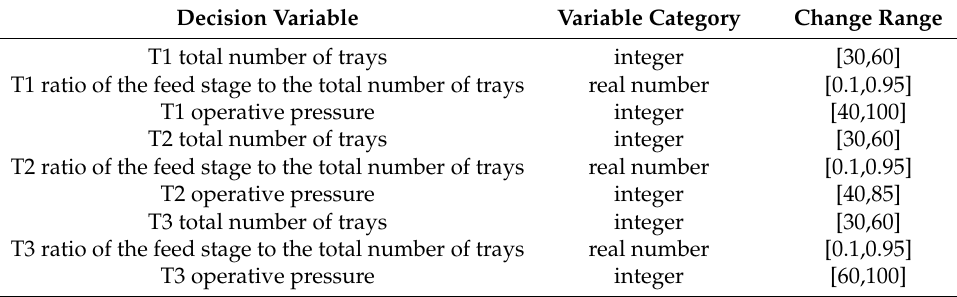
Table 4. Range of variation in population individual.